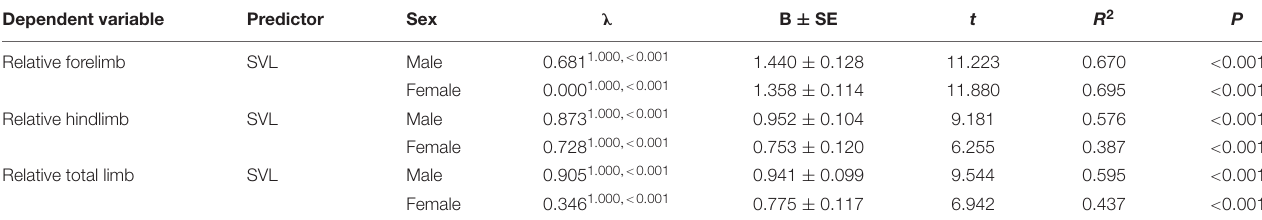
TABLE 2 | Relationship between relative limb muscle mass and body size (SVL) in males and females among species of anurans.